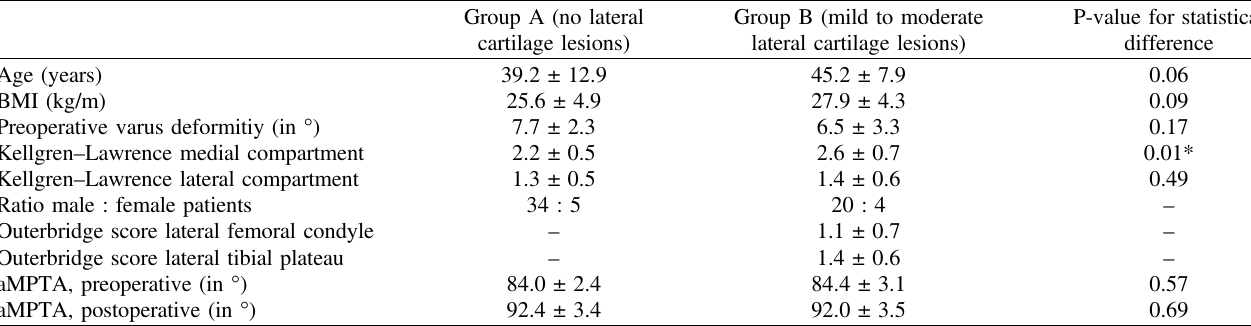
Table 1. Demographic and surgical data of Group A and Group B at the time of surgery.